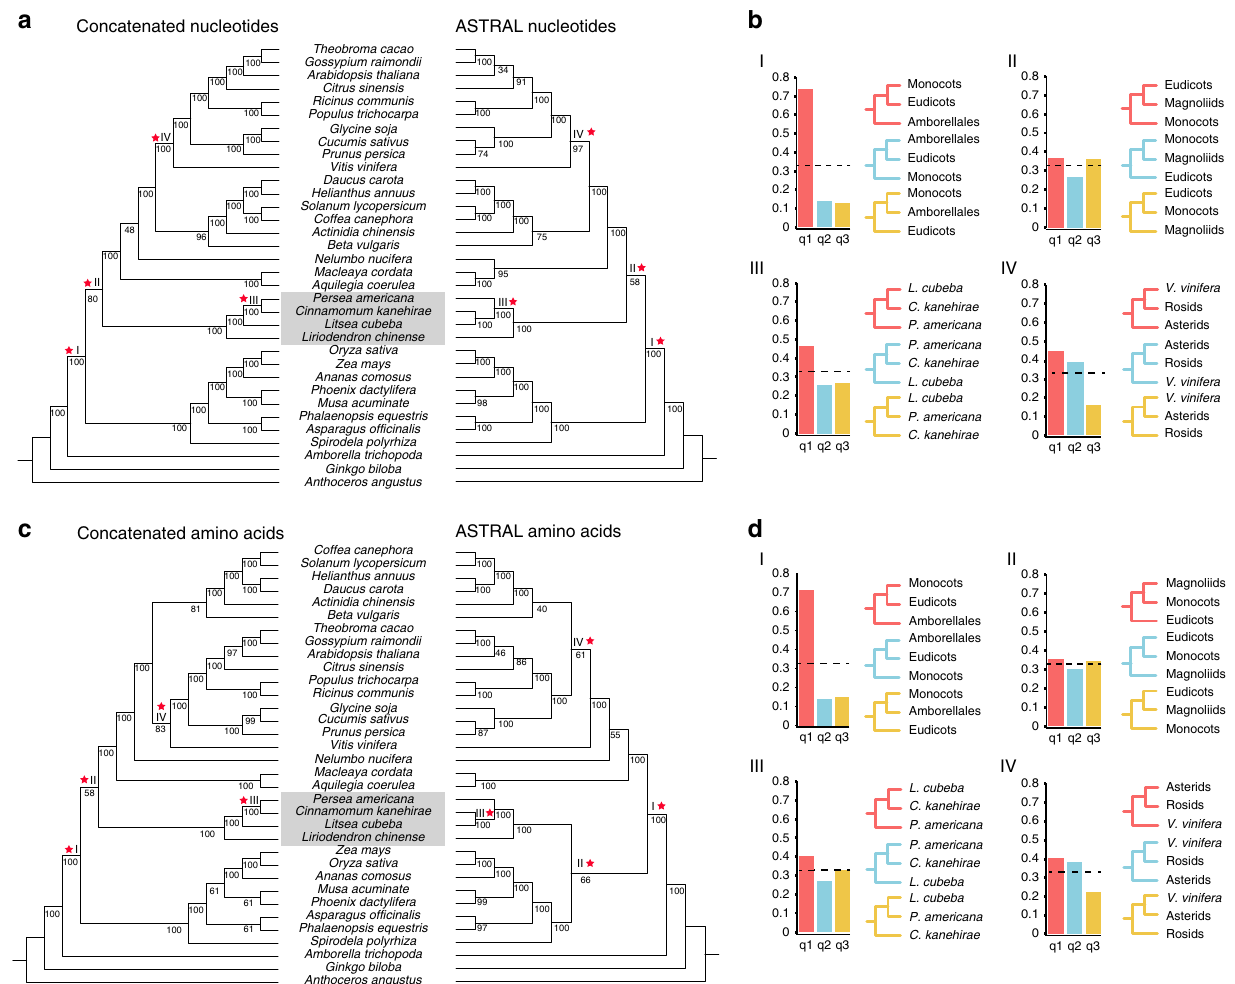
Fig. 1 Concatenated- and ASTRAL-based phylogenetic trees. a Phylogenetic trees based on the concatenated (left) and multi-species coalescent (MSC) methods (right) using nucleotide sequences. Magnoliids are indicated with a gray background. Red stars with labels I, II, III, and IV refer to the discussions on phylogenetic discordances (see text). b Estimated proportions of the 160 single-copy gene trees with different topologies based on nucleotide alignments. The x -axis labels q1, q2, and q3 refer to the quartet support for the main topology (red), the fi rst alternative (blue), and the second alternative (yellow), respectively. The dashed line refers to a proportion of 0.33. c Phylogenetic trees based on the concatenated (left) and MSC methods (right) using amino acid sequences. Interpretation is as in a . d Estimated proportions of the 160 single-copy gene trees based on amino acid sequences. Interpretation is same as b . Source data underlying ( a ) and ( c ) are provided as a Source Data fi (MSC)-based phylogenomic analyses using ASTRAL 27 by con- sidering each gene tree from the 160 single-copy gene families separately (Fig. 1a, c, right side). The MSC-based phylogeny using nucleotides (Fig. 1a, right side) again supports a sister group relationship between Magnoliids and eudicots, to the exclusion of monocots. However, the MSC-based tree using amino acids (Fig. 1c, right side) suggests Magnoliids to form a sister group with monocots, after their divergence from eudicots. To evaluate the discordance of gene trees in our single-copy gene data set, we trees in support of the main topology (q1), and the fi rst (q2) and